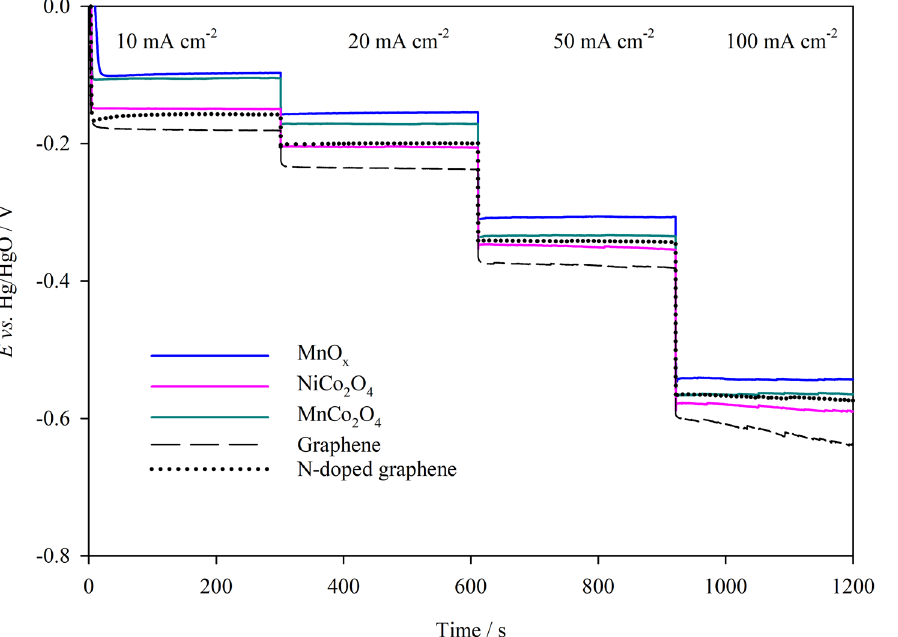
Figure 5. Chronopotentiometric measurements of GDE samples at 10 to 100 mA cm −2 in 1 M NaOH, 333 K, O 2 flow rate of 200 cm 3 min −1 .